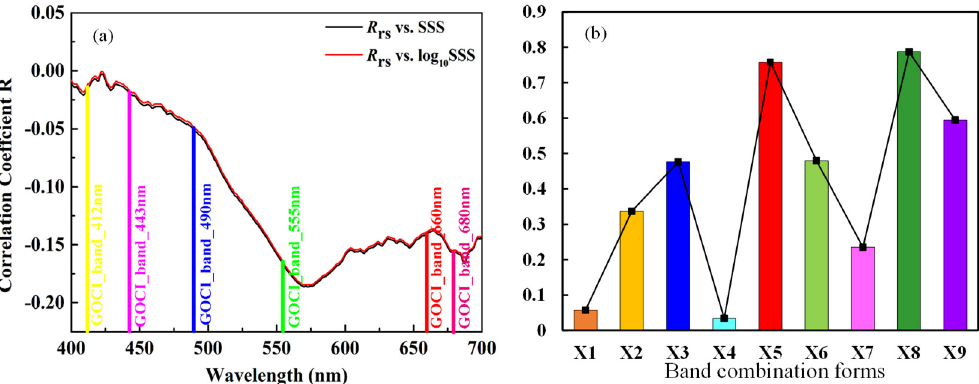
Figure 3. ( a ) Spectral distribution of the correlation coefficients between Rrs( λ ) and SSS (black line) and log 10 SSS (red line) in the range of 400–700 nm; ( b ) Correlation coefficients between nine band combination forms derived from the 6 GOCI bands and log 10 SSS. The expressions of different band forms are listed in Table 1.